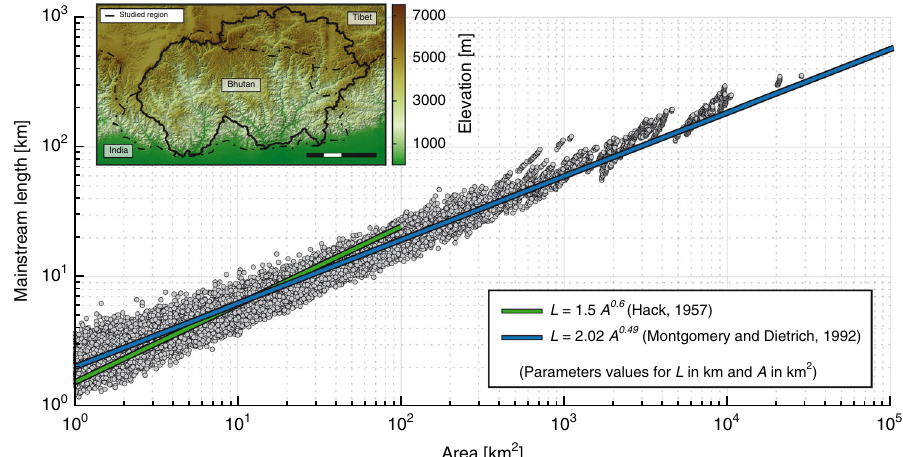
Fig. 1 ‘ Length – Area ’ dataset from ca. 22,000 river basins (grey circles) in Bhutan Himalaya. Green and blue lines show the original Hack ’ s law 2 and the law proposed by Montgomery and Dietrich 11 , respectively. Inset shows topographic map of Bhutan region with the limits of the studied region. Scale bar: 100